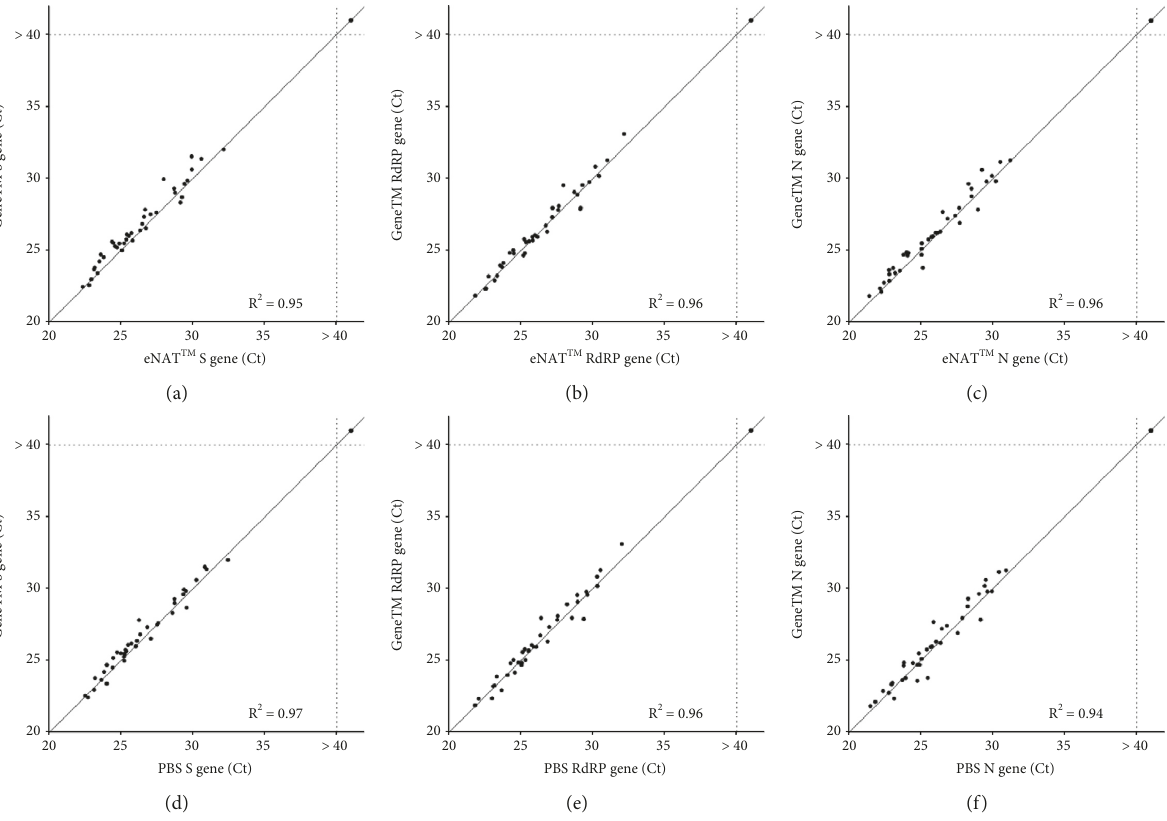
Figure 3: Comparison of the Ct values (determined by real-time PCR) for the three SARS-CoV-2 genes in the 46 NPS samples that were positive or negative for the virus. Samples were diluted in GeneTM, eNAT ™ , or PBS. Comparison of the (a) S gene, (b) RdRP gene, and (c) N gene in NPS samples diluted in GeneTM and eNAT ™ . Comparison of the (d) S gene, (e) RdRP gene, and (f) N gene in NPS samples diluted in GeneTM and PBS. Two replicates per sample were assayed using real-time PCR under the indicated conditions. Ct, cycle threshold; S gene, spike gene; RdRP gene, RNA-dependent RNA polymerase gene; N gene, nucleocapsid